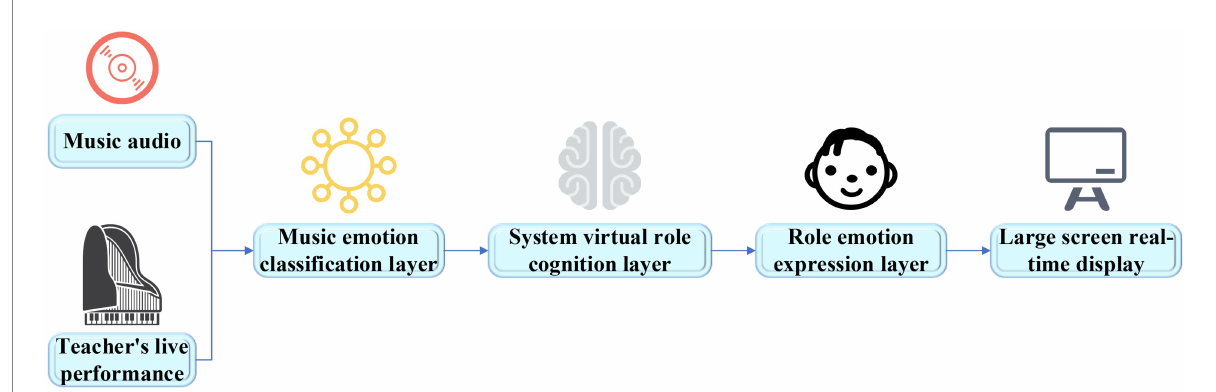
FIGURE 10 The architecture of the visual system of music emotion